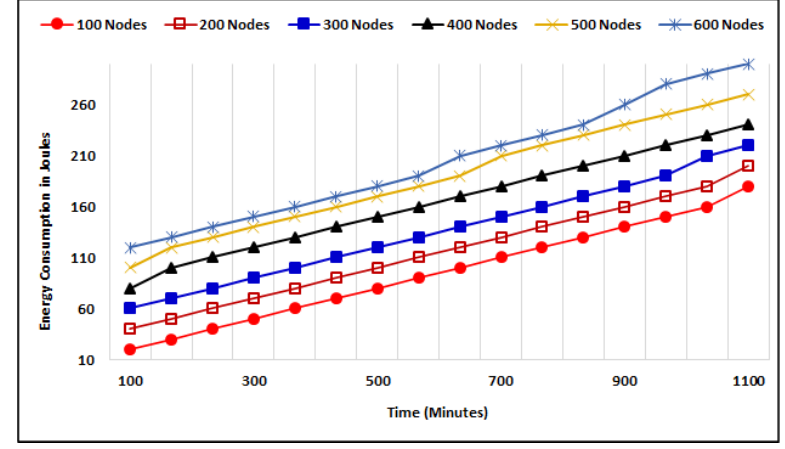
Figure 14. Energy consumption with varying nodes.